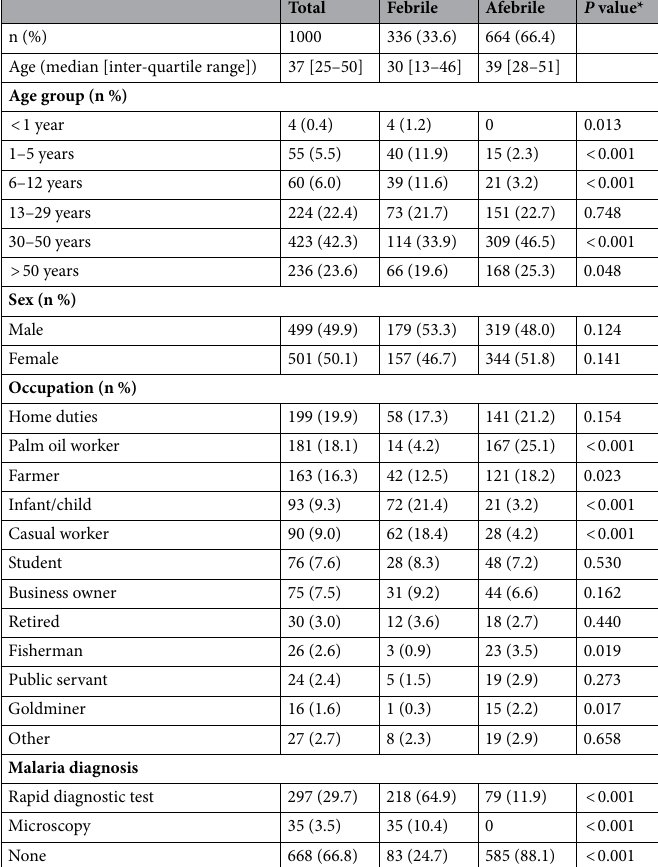
Table 1. Sample characteristics. *For febrile versus afebrile participants by Chi-squared